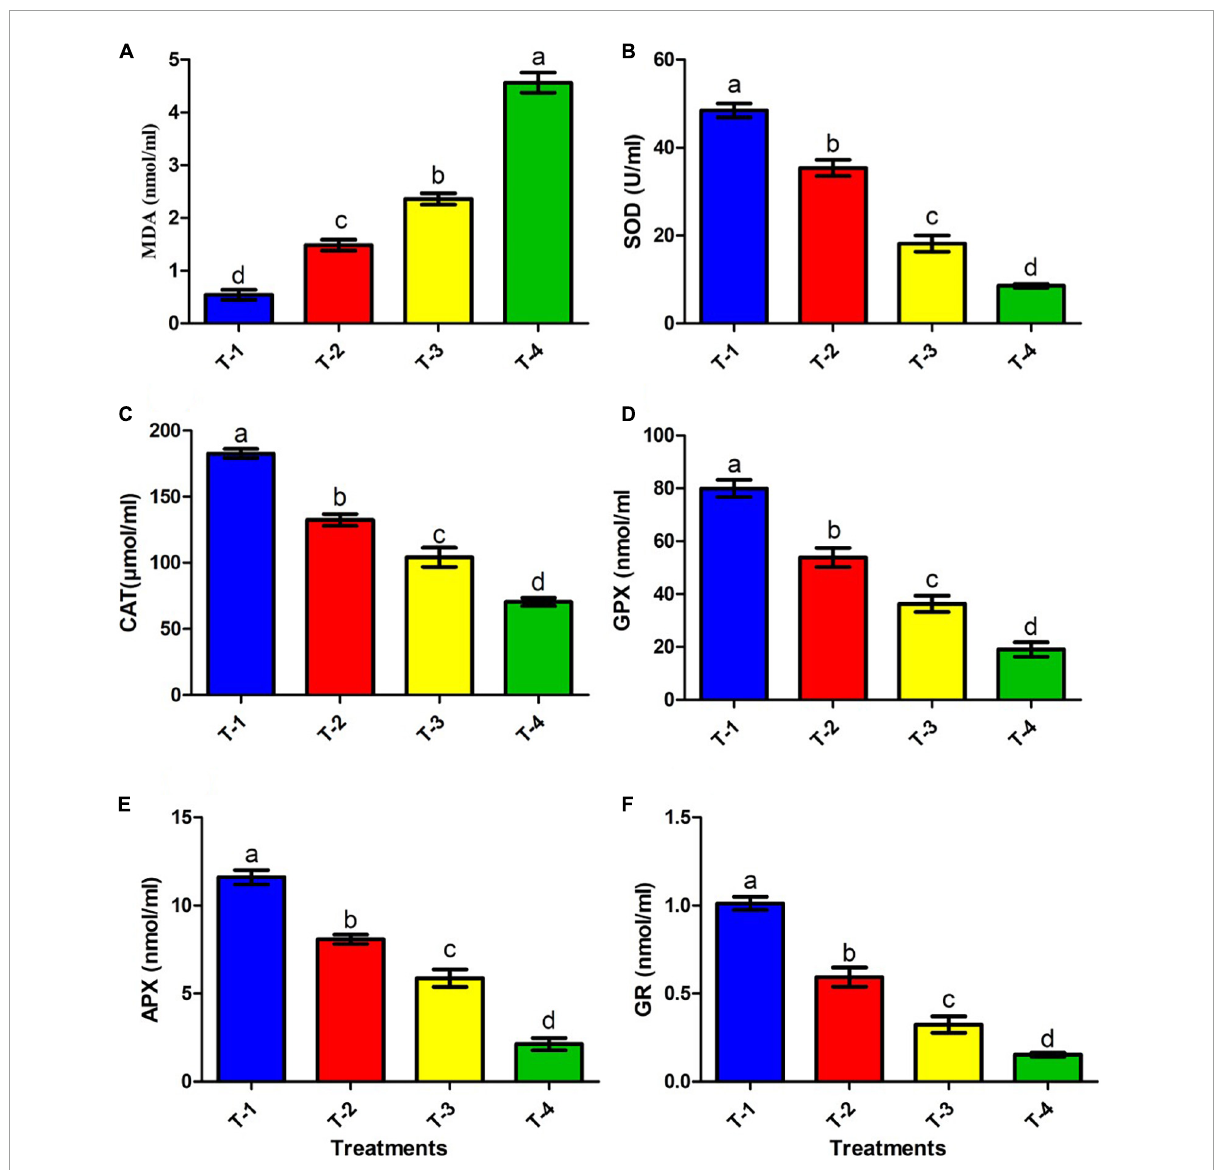
FIGURE5 Effect of CBZM stress on antioxidant enzyme activities of rhizobacteria isolates ANCB-12. (T-1) No CBZM concentration, (T-2) 1,000 µ g/ml CBZM, (T-3) 2,000 µ g/ml CBZM, and (T-4) 3,000 µ g/ml CBZM. (A) MDA content, (B) SOD activity, (C) CAT activity, (D) GPX activity, (E) APX activity and (F) GR activity. The data represent the mean ± SEM ( n = 3) of three replicates. The error bars display the standard error mean (SEM). Letters on each bar denote significant variances ( p ≤ 0.05) according to the DMRT